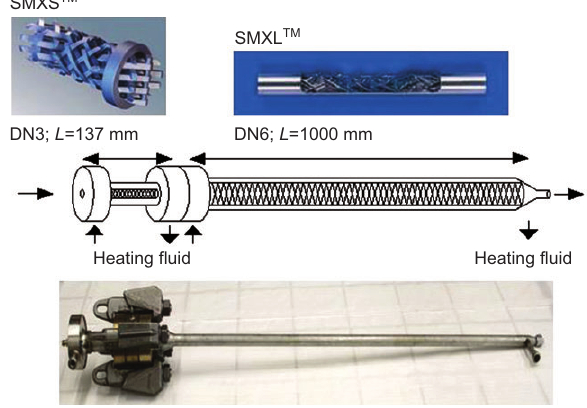
Figure 3 Milli-reactor containing static